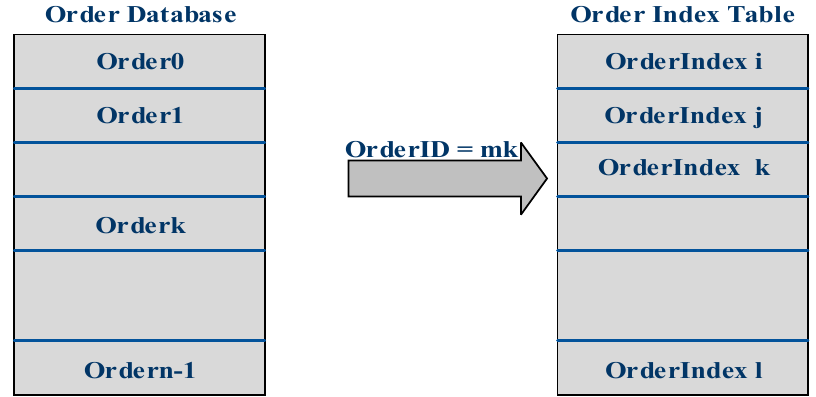
Figure 5. Order database and order index table.